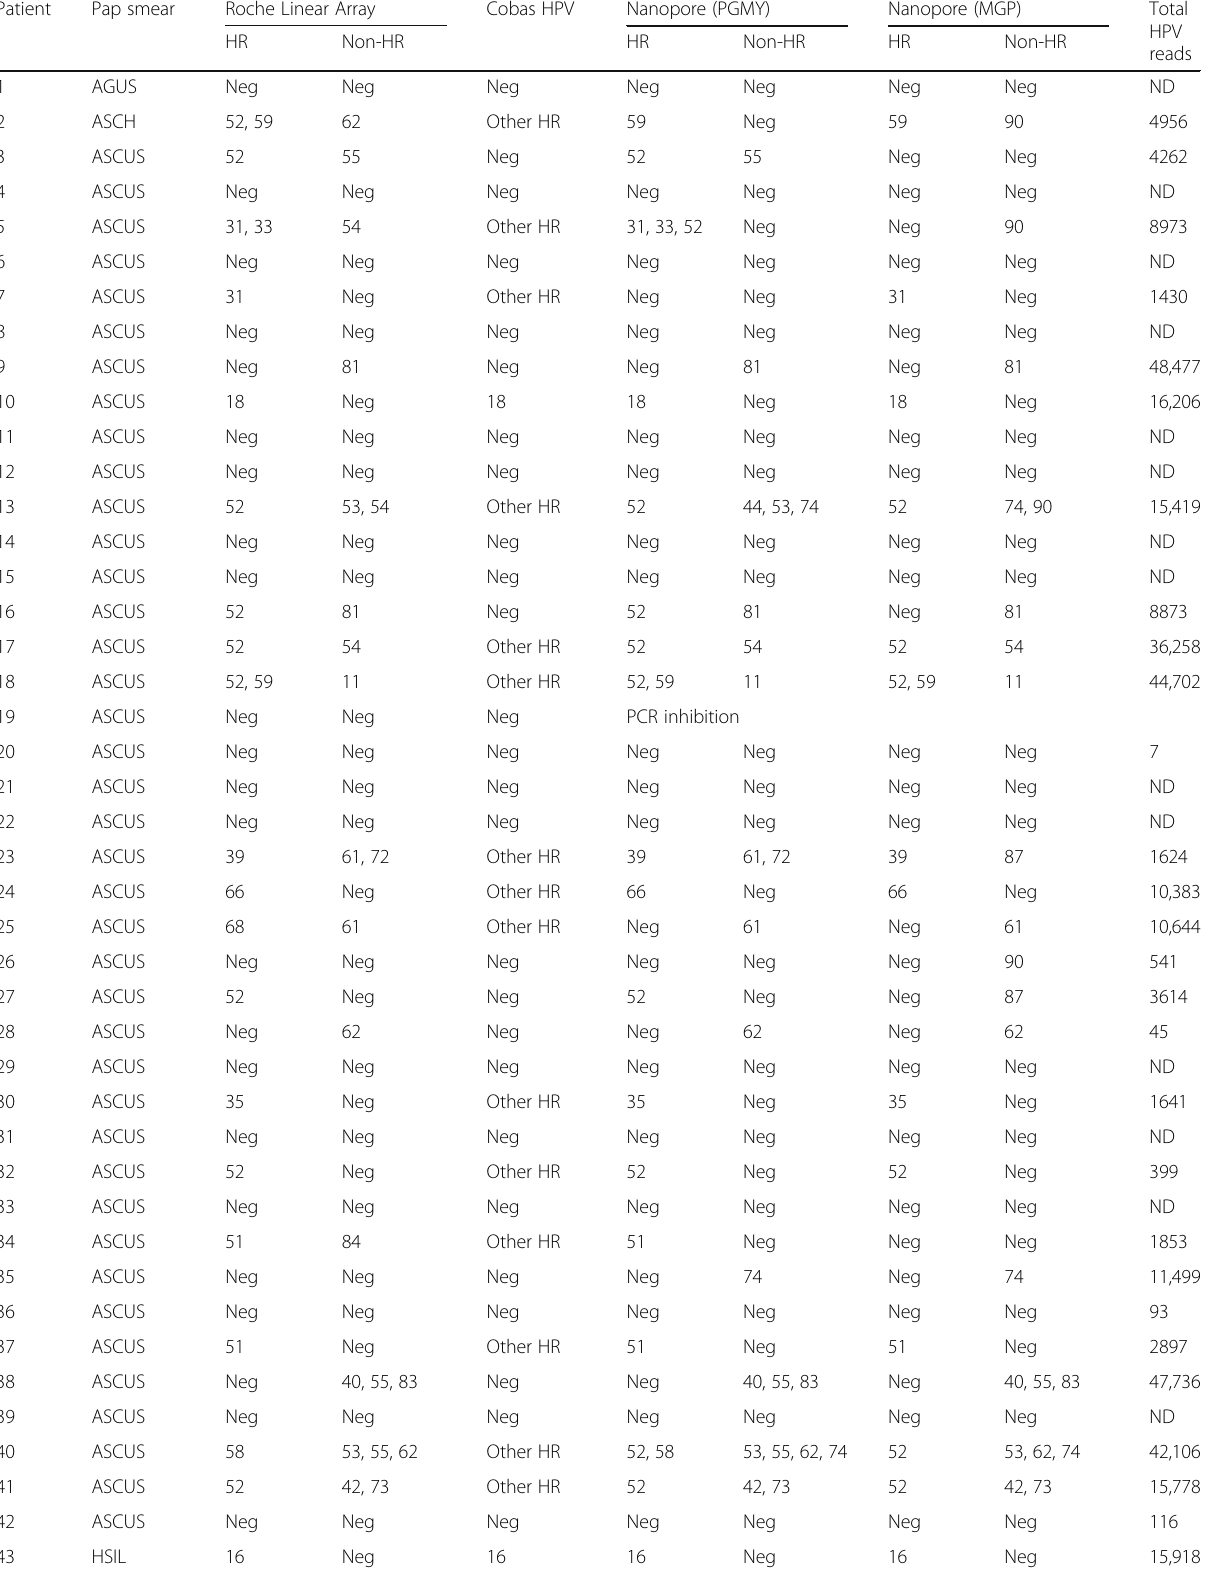
Table 1 Results of Pap smear, cobas HPV Test, Roche Linear Array HPV Genotyping Test, and Nanopore